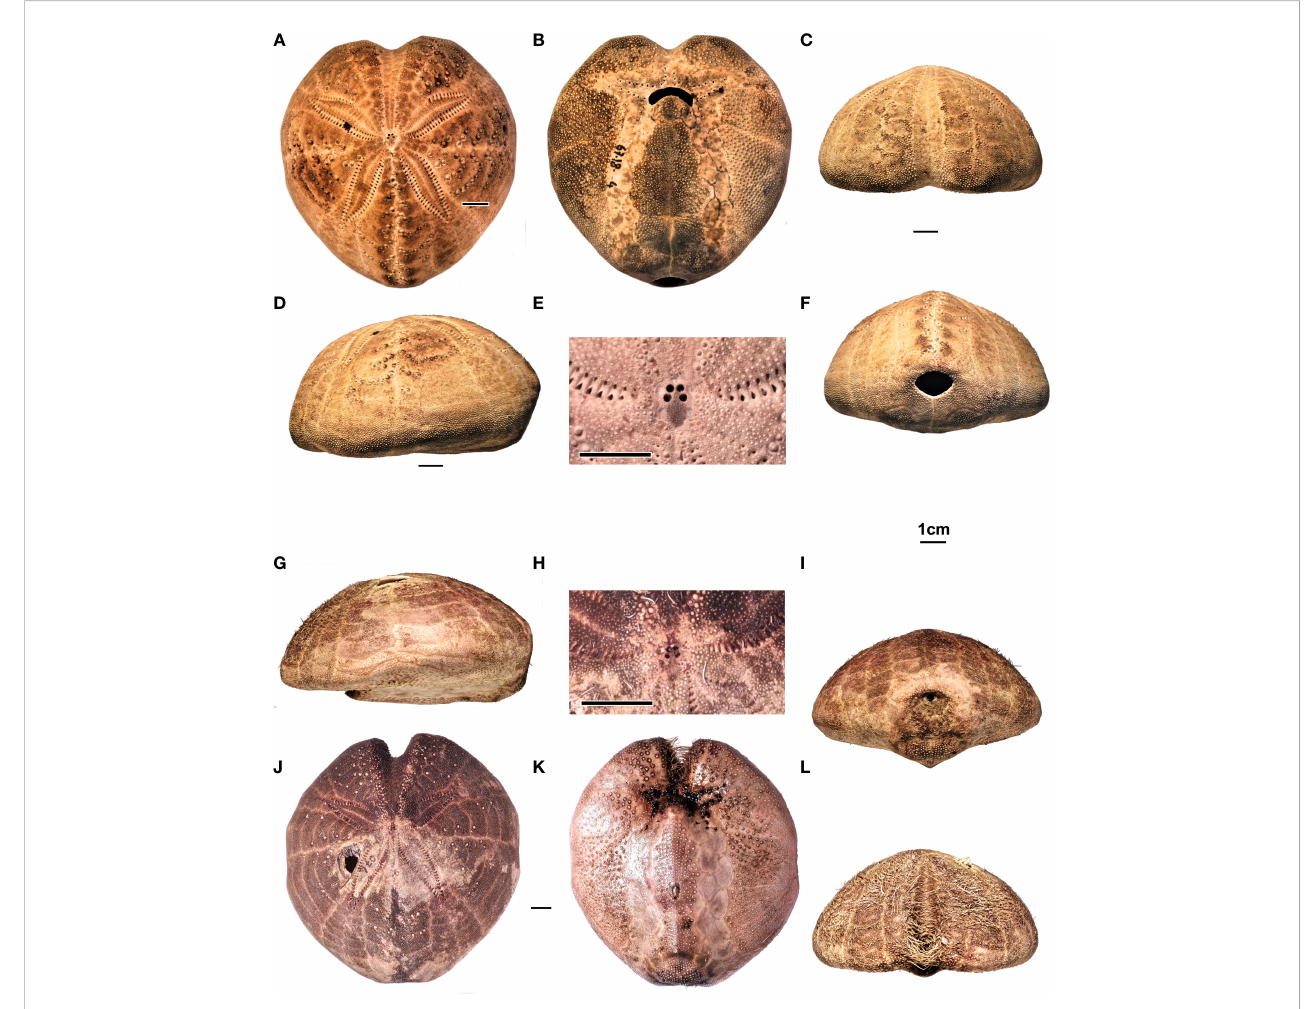
FIGURE 11 (A – F) Spatangus purpureus , Sardinia. Specimen MZ UNICA 067-MED18-4. In order, (A – D) aboral, adoral, frontal, and lateral views; (E) detail of the apical disc; (F) posterior view. (G – L) Propespatagus sp. 1, Sardinia. Specimen 074-MED18-2, holotype: (G) lateral, (I) posterior, (K) adoral, and (L) frontal views. Specimen 074-MED 18-1, (J) aboral view. Specimen MZ UNICA 085-MED18-1, (H) apical disc,